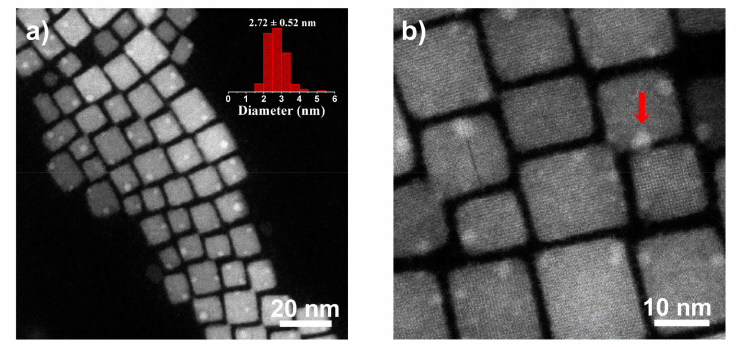
Figure 1. Overview STEM-HAADF images of the NPs on the CsPbBr 3 NCs at different magnifications. The inset of ( a ) shows the size distribution of over 300 NPs. The red arrow in ( b ) indicates a NP bridging itself between two CsPbBr 3